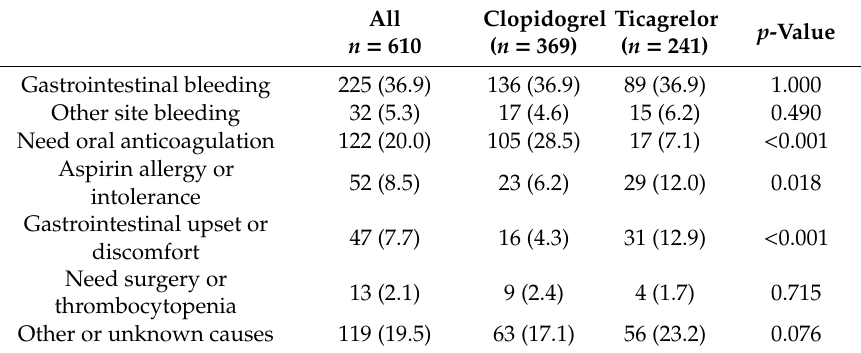
Table 1. Reasons for premature stop of